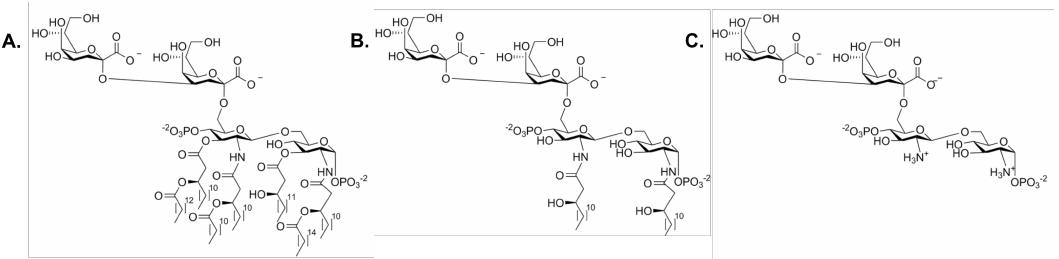
Figure 8. Strucutres of Kdo 2 -lipid A and analogues: ( A ) E. coli Kdo 2 -lipid A; ( B ) O-deacylated E. coli Kdo 2 -lipid A (ODLA) and ( C ) fully deacylated E. coli Kdo 2 -lipid A